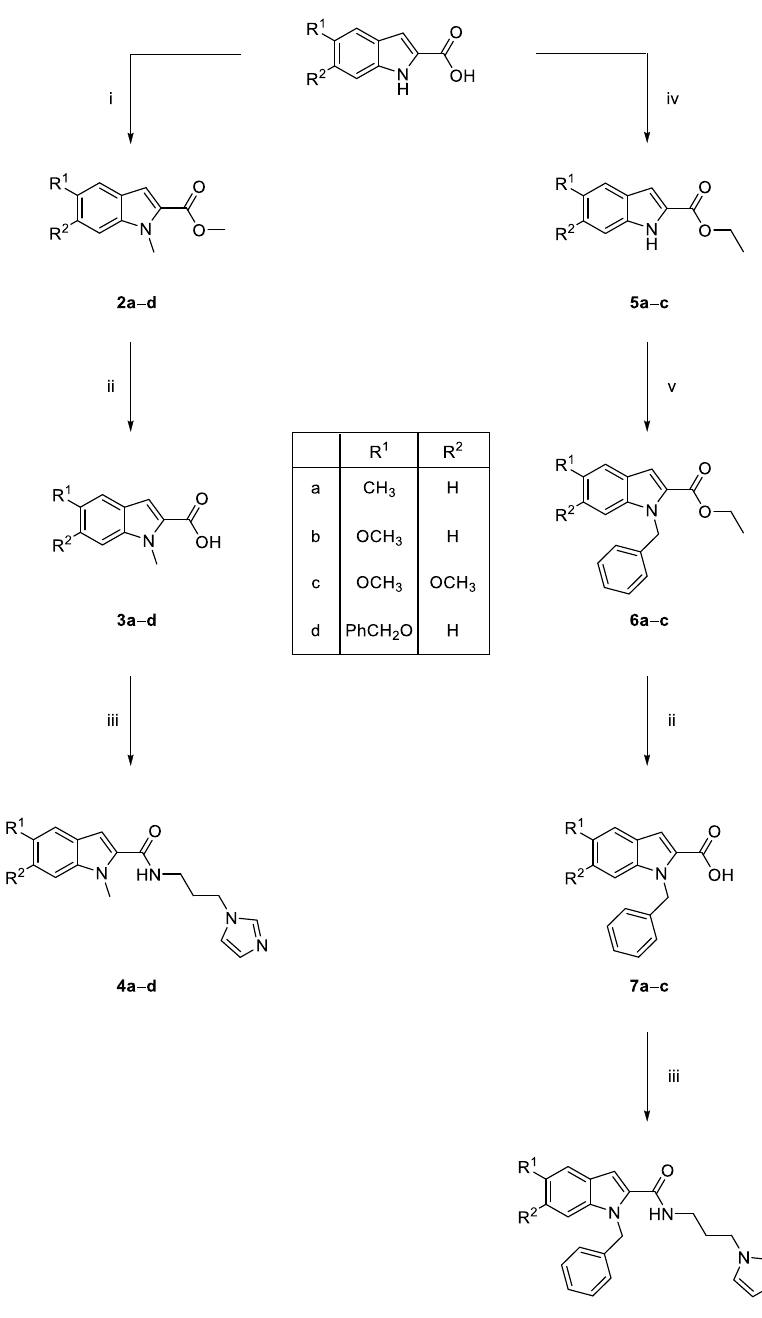
Scheme 2. Synthetic procedure adopted for the synthesis of compounds 4a ‒ d and 8a ‒ c .